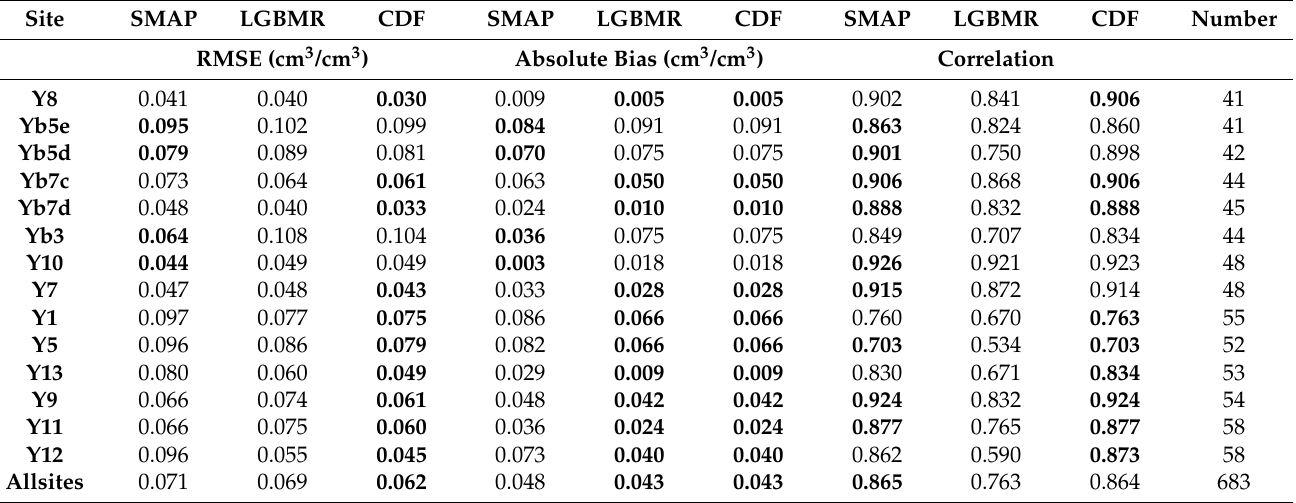
Table 5. Summary of the SSM comparisons among SMAP 9-km, LightGBRegressor 3-m, and addi- tional CDF matching 3-m results for the dates when all three data sets were available. Bold numbers denote the best model performance at each